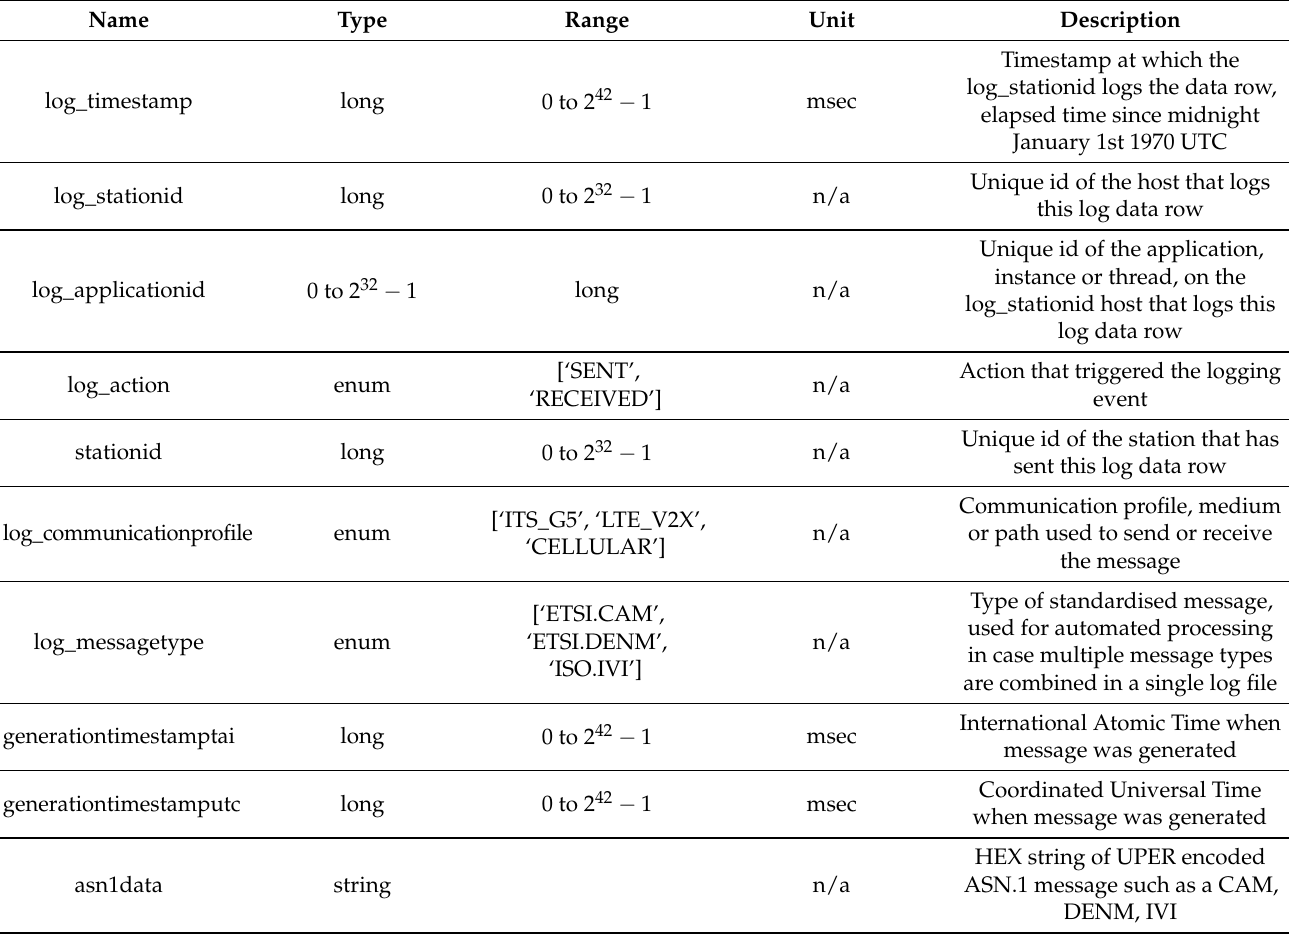
Table 3. Logging